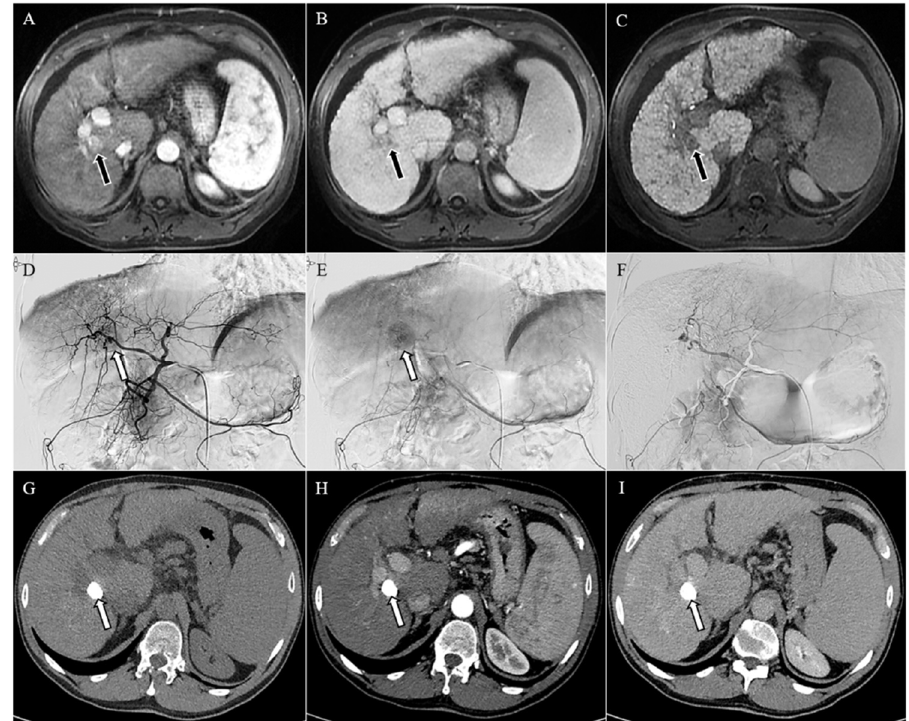
Figure 1. Magnetic resonance imaging ( A – C ) showing a lesion of 18 mm in the liver segment 8, hypervascularized in the arterial phase (arrow in ( A )), with washout of the contrast media in the venous phase (arrow in ( B )), and hypointense in the hepatobiliary phase (arrow in ( C )), consistent with hepatocellular carcinoma in the context of cirrhosis. Angiographic study ( D – F ) of the liver confirmed the hypervascular lesion in the early and late arterial phases (arrows in ( D , E ), respectively), which was no longer visible after chemoembolization ( F ). Computed tomography ( G – I ) performed one month after chemoembolization demonstrated an homogeneous accumulation of the lipiodol in the unenhanced image (arrow in ( G )), with no signs of relapse in the arterial and delayed phases ( H,I ). Table 2. Laboratory data after conventional